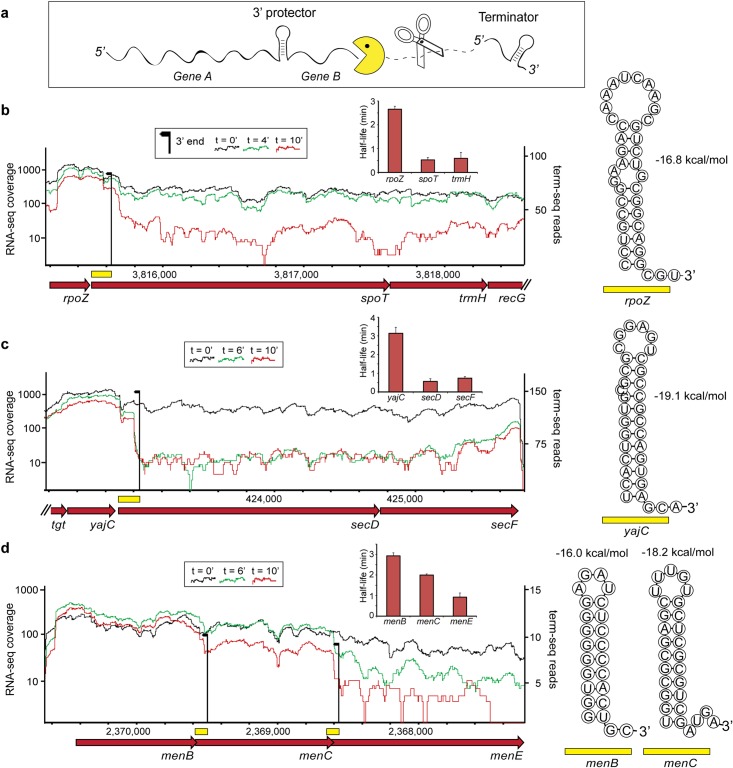
Protective RNA 3’ structures at the boundaries of differentially decaying transcript regions.(A), A model for differential decay in operons in which the 5’-most gene is preferentially stabilized, as described for the maltose operon [8]. Scissors and Pac-Man represent endonucleases and 3’-5’ exonucleases, respectively. (B-D), Differential decay in three representative E. coli operons, depicted by normalized RNA-seq coverage in steady state (black, t = 0) or at two time points (green and red) following rifampicin treatment. Bar graphs show average half-life calculations with error bars representing standard deviation. RNA-seq coverage was normalized by the number of uniquely mapped reads in each library. RNA 3’ ends detected by term-seq are shown as black arrows with the height of the arrow representing the total number of supporting reads. The sequences present immediately upstream to the recorded 3’ ends were folded using RNAfold [35] and are shown to the right of each coverage plot, with the estimated structure stability, measured in kcal/mol.